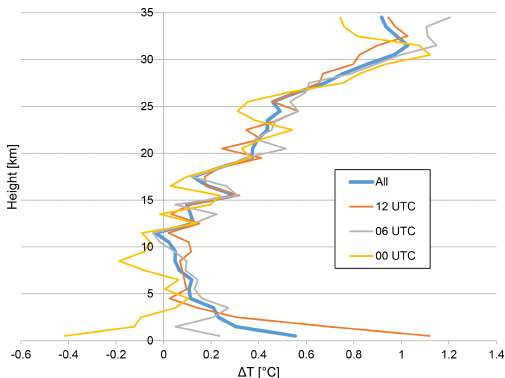
Figure 16. The temperature differences between ascent and descent as a function of height (Praha-Libus data).